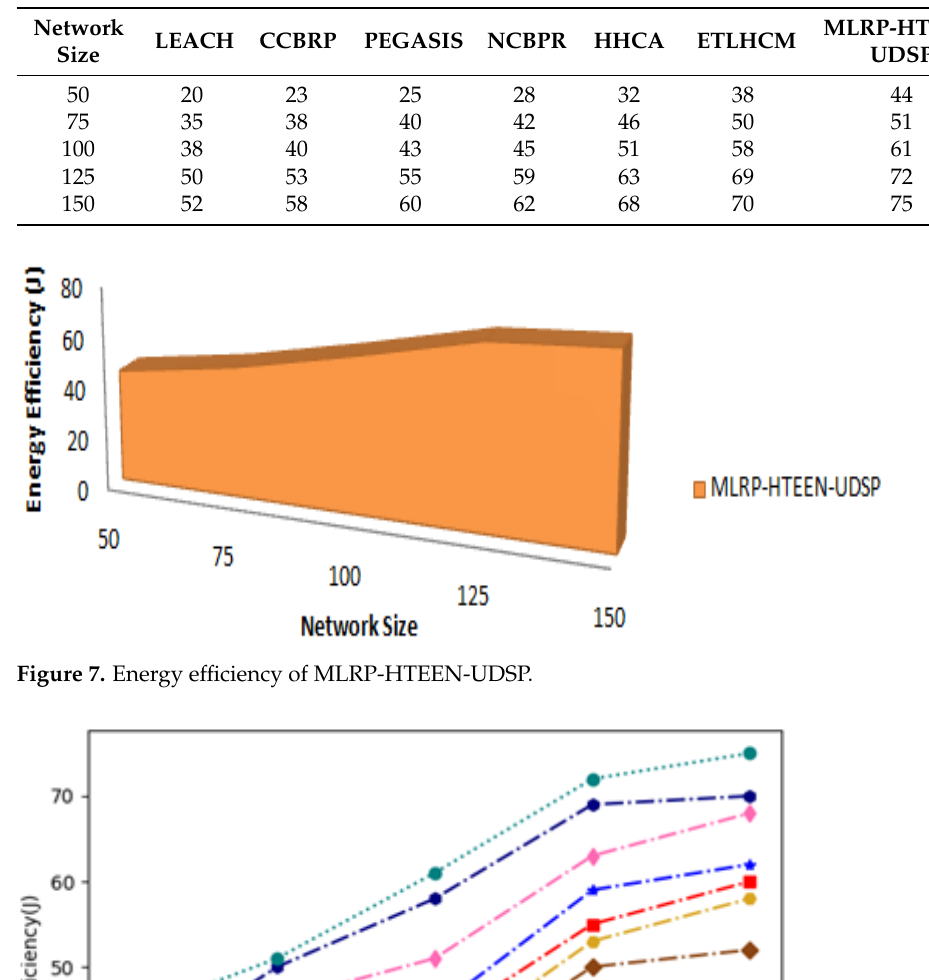
Figure 8. Comparison of energy efficiency.